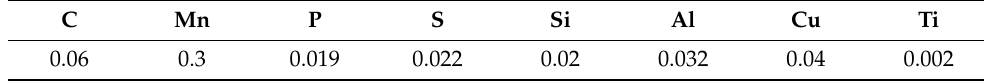
Table 3. Mechanical properties of Araldite 2015 [31]. Table 1. Chemical composition of steel (% by weight).